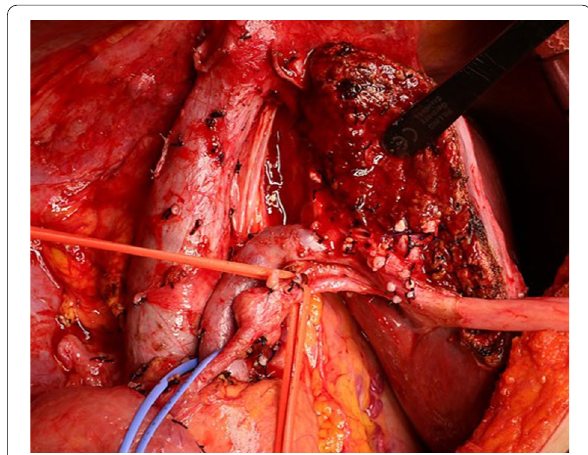
Fig. 3 A right hepatic trisectionectomy and caudate lobectomy with extrahepatic bile duct resection including regional lymph adenectomy for gallbladder cancer are completed